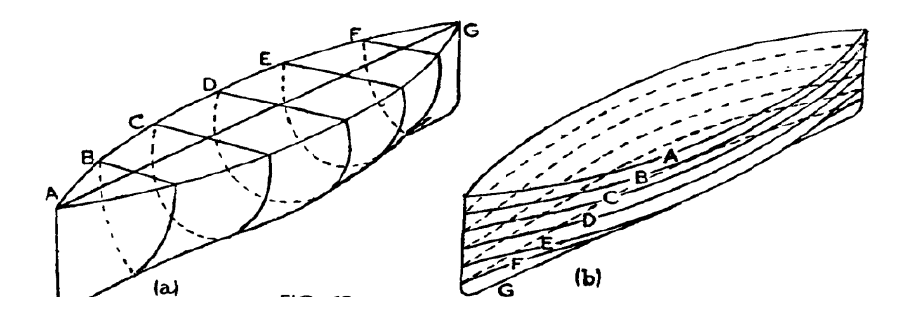
Source : Adapted from Pursey (1996)